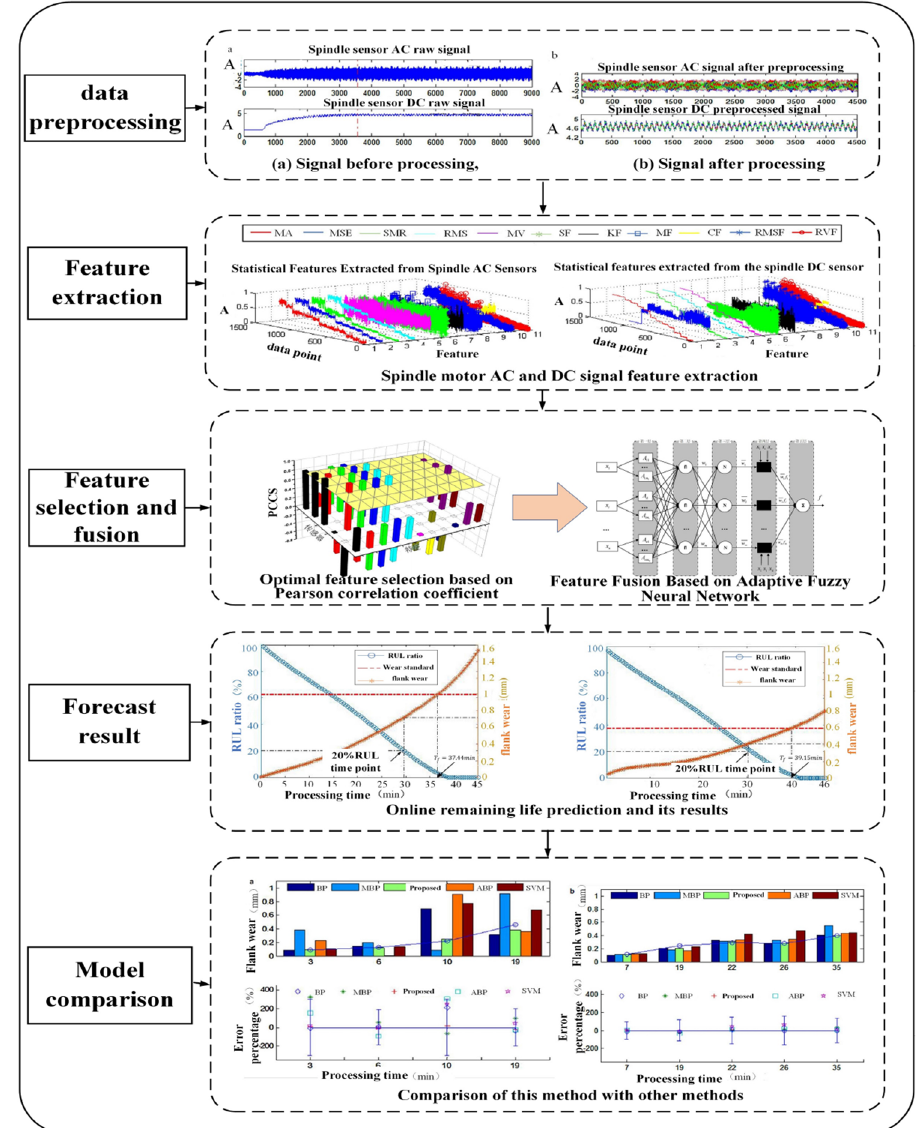
Fig. 12 The prediction model of Pearson correlation coef- ficient based on fuzzy neural network